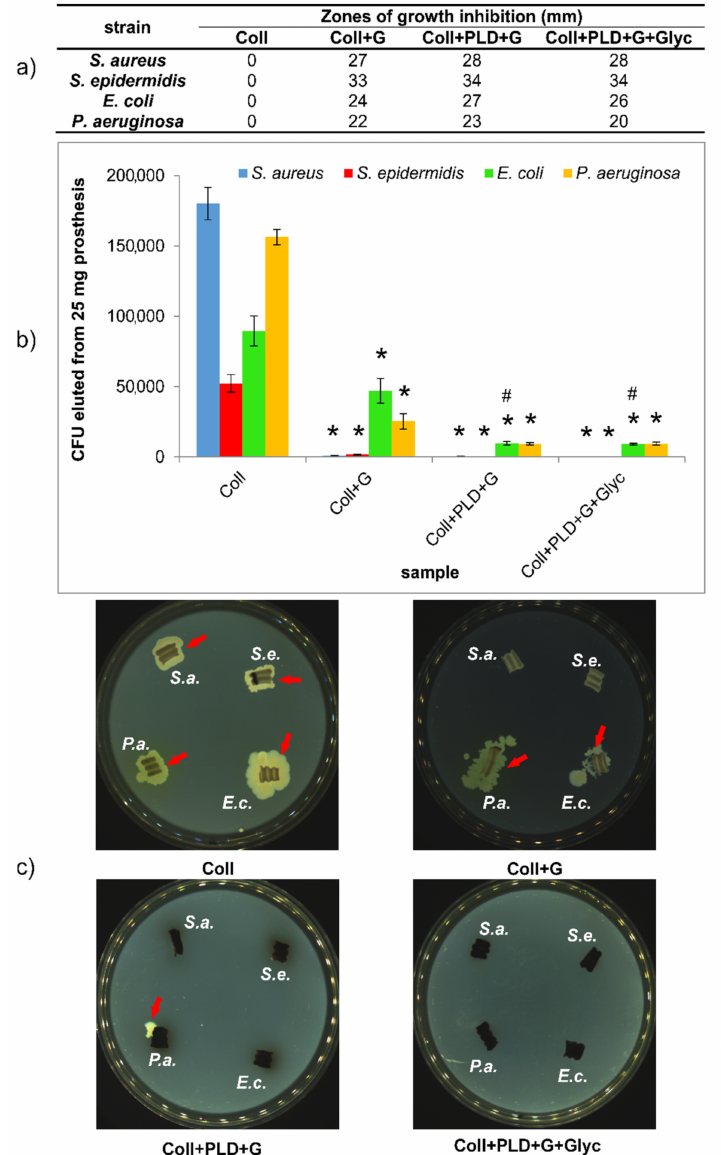
Figure 8. Short-term antibacterial activity of gentamicin-bound Coll+G, Coll+PLD+G and Coll+PLD+G+Glyc prostheses against four reference strains in comparison with Coll grafts. ( a ) Zones of bacterial growth inhibition; ( b ) bacterial adhesion expressed as the amount of prosthesis-adhered cells; ( c ) bacterial adhesion presented as spreading of adhered cells on solid culture medium. S.a.— S. aureus ; S.e.— S. epidermidis ; E.c.— E. coli ; P.a.— P. aeruginosa . (*) symbol indicates statistically significant results for Coll prosthesis in comparison to the rest of samples, (#) symbol indicates statistically sig- nificant results for Coll+G prosthesis in comparison to Coll+PLD+G and Coll+PLD+G+Glyc samples, according to one-way ANOVA with post-hoc Tukey’s test ( p <